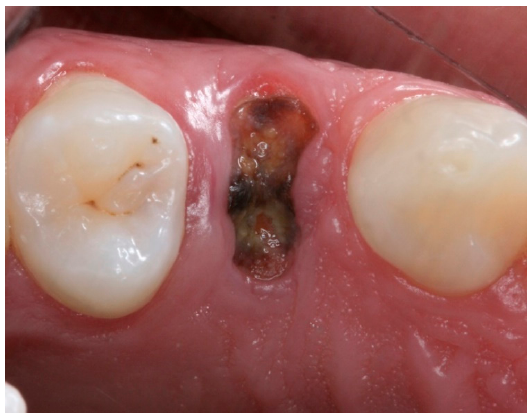
Figure 2. Intraoral occlusal preoperative view of tooth